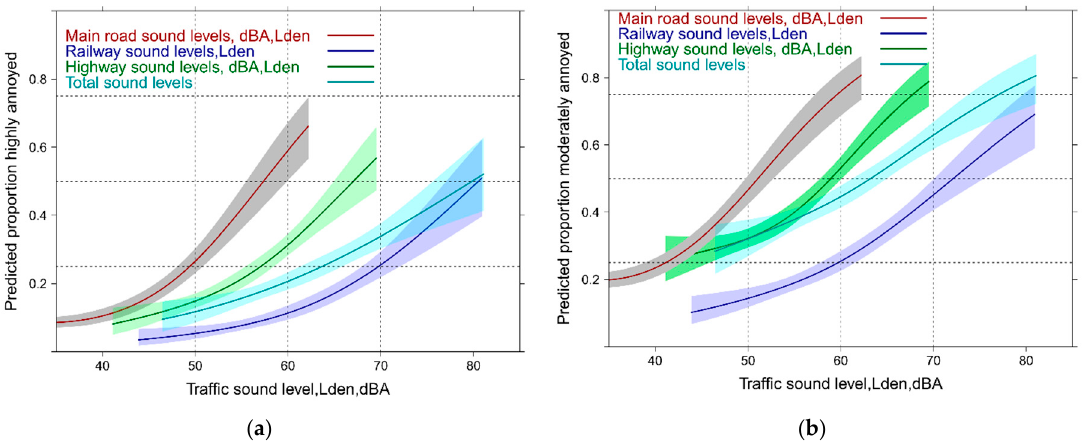
Figure 1. Predicted proportion of high and moderate annoyance associated with single source specific and total sound exposure (total annoyance). ( a ) Proportion highly annoyed; ( b ) Proportion moderately annoyed.